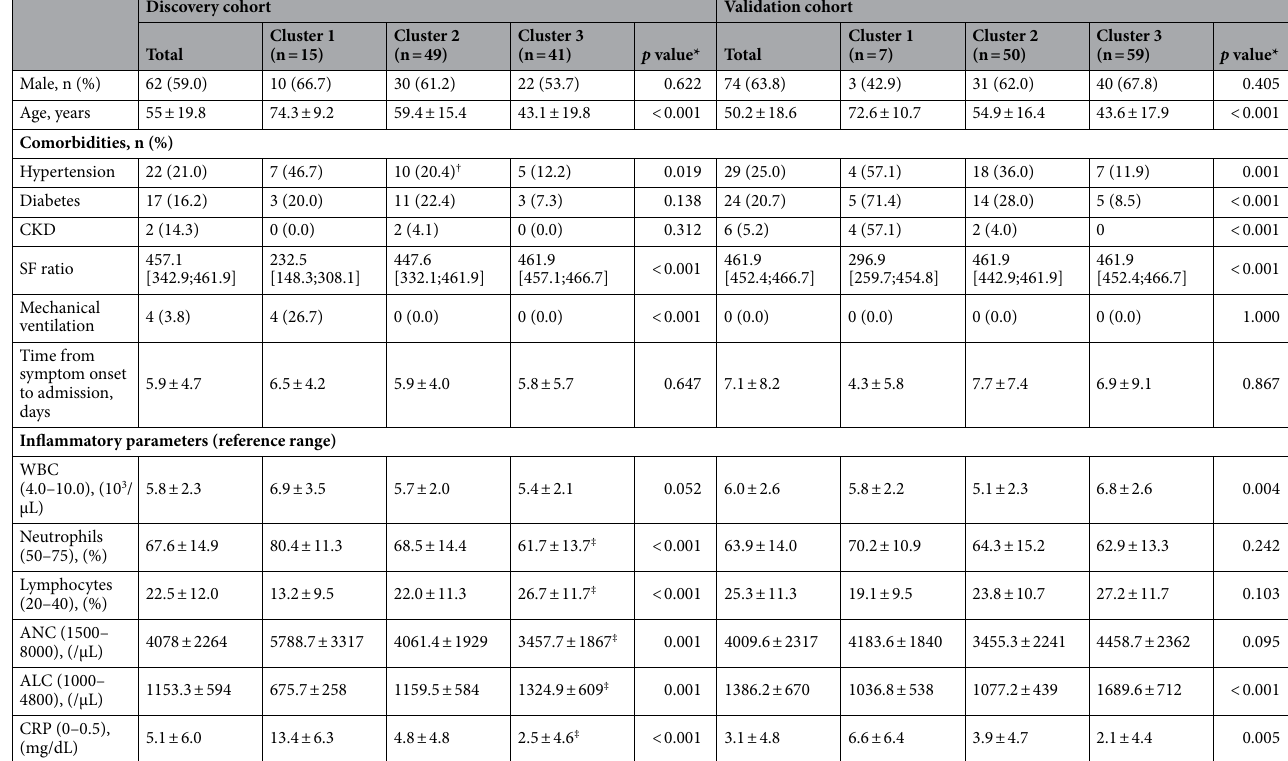
Table 1. Baseline characteristics of the patients in the discovery cohort and the validation cohort on admission (according to the clusters). Results are expressed as the mean ± standard deviation or as n (%). * p values were analyzed by one-way ANOVA. † No difference with other two clusters (p > 0.05 by post-hoc multiple comparison). ‡ No difference with Cluster 2 (p > 0.05 by post-hoc multiple comparison). ALC